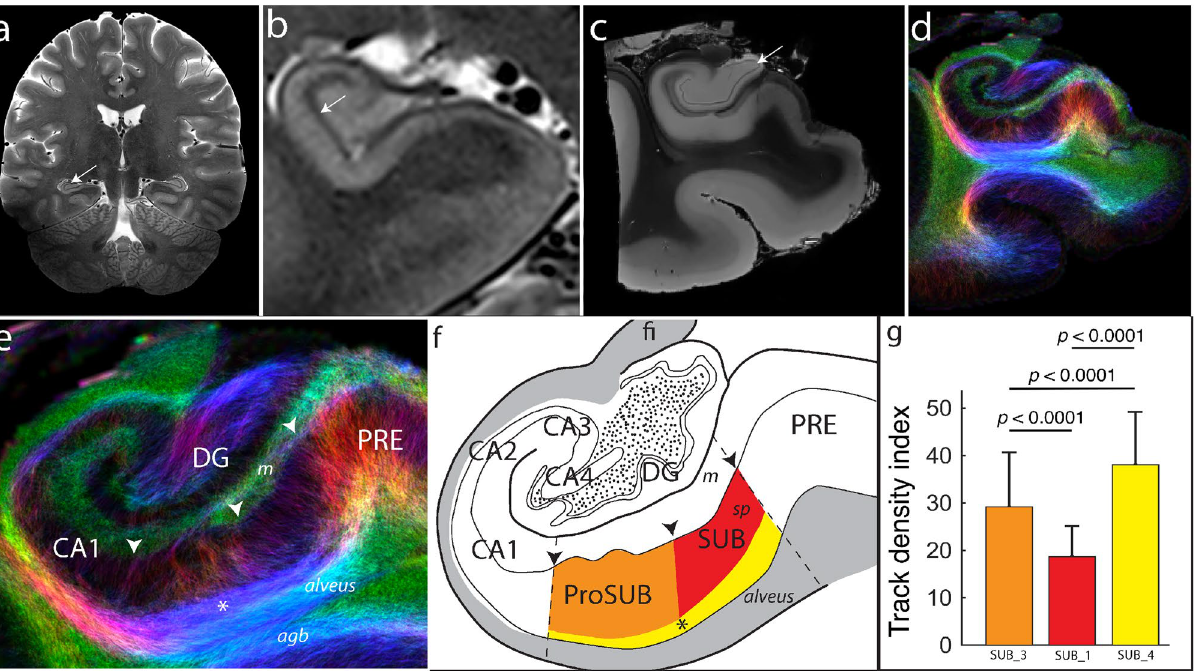
Figure 6. Tissue microstructure imaging resolution compared to gene expression segmentation. ( a ) 2D turbo spin echo T2w whole brain 7 T in vivo MRI image acquired at 200 µm in-plane resolution with 2 mm thickness (arrow points to hippocampus). ( b ) Zoomed in 7 T MRI image of the hippocampus at a different rostrocaudal level showing the major hippocampal strata. The strata radiatum and stratum lacunosum moleculare in hippocampus proper as well as the SUB molecular layer appear as a dark band (arrow) that can help distinguish major hippocampal subregions. ( c ) Ex vivo T1w 16.4 T MRI image ((50 μm) 3 resolution) of a dissected post- mortem tissue sample from the temporal lobe. At this resolution, additional anatomical features are apparent including the granule cell layer of the dentate gyrus (arrow). ( d ) Fiber track density of the postmortem tissue sample obtained from high resolution angular diffusion imaging at 16.4 T (150 μm 3D isotropic resolution). ( e ) Zoomed in view of the fiber track density in the hippocampus of the post-mortem sample with comparison to the gene expression-based atlas segmentation ( f ). Arrowheads in ( e ) and ( f ) mark the corresponding gene expression domain boundary positions. The ProSUB is distinguished from the adjacent SUB by the presence of several thicker dorsoventrally-oriented fiber bundles (orange/red boundary in atlas). In addition, a mediolateral fiber track dorsal to the alveus (asterisk) corresponds to the deep layer of cells located in both the ProSUB and SUB (yellow atlas area). ( g ) Average fiber track density within each region’s voxel (colors correspond to atlas regions in ( f ); mean ± S.D.). Abbreviations: agranular bundle (agb), dentate gyrus (DG), fimbria (fi), molecular layer of the subiculum (m), presubiculum (PRE), prosubiculum (ProSUB), stratum pyramidale of the subiculum (sp), subiculum